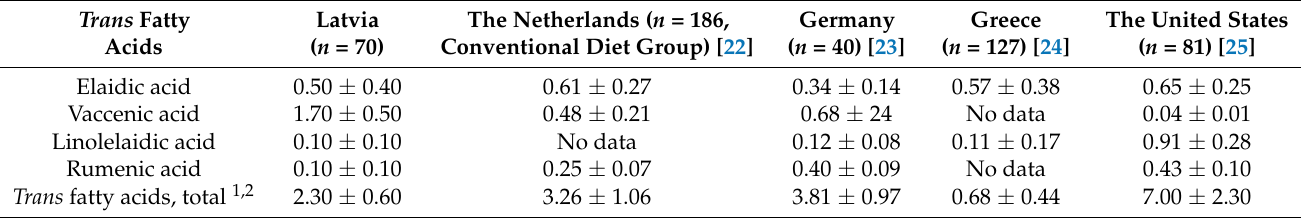
Table 6. The trans fatty acid level (% of total fatty acids) in human milk. Data from different countries. Trans Fatty Latvia The Netherlands ( n = 186, Acids Elaidic